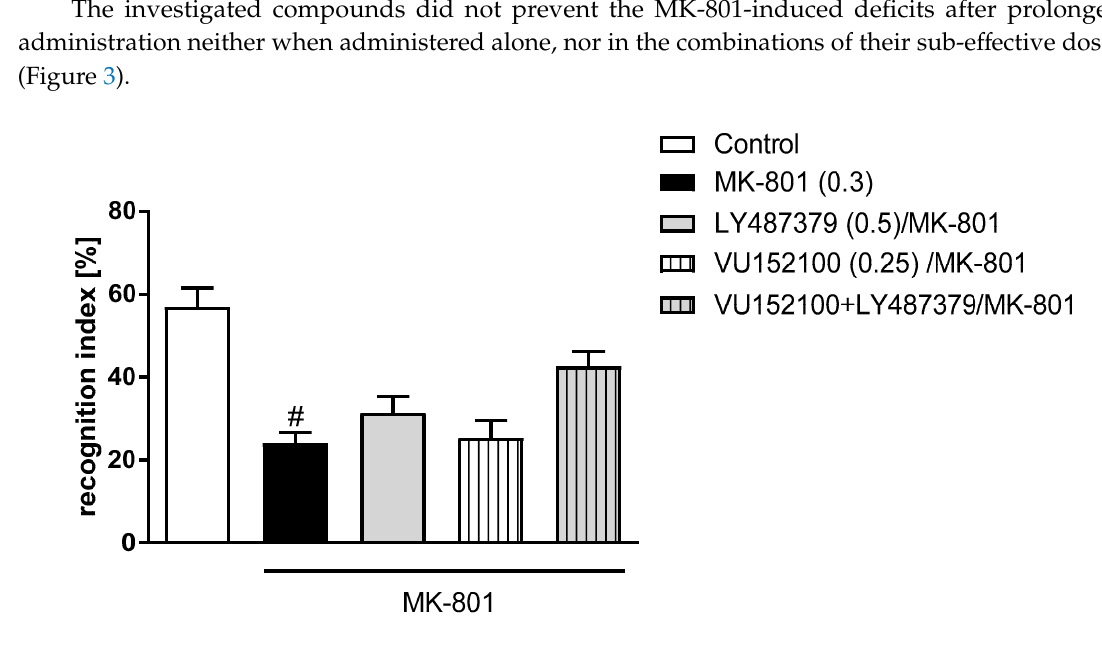
Figure 3. Novel object recognition test in mice after chronic administration (7 days) of investigated compounds in acute MK-801 model. Investigated doses are indicated in parentheses. Bars represent the means ± SEM. N = 8–10/group. # p < 0.001 versus the control group. 2.2.3. Effectivity of Acutely Administered Compounds in Animals Repeatedly Treated with MK- 801.